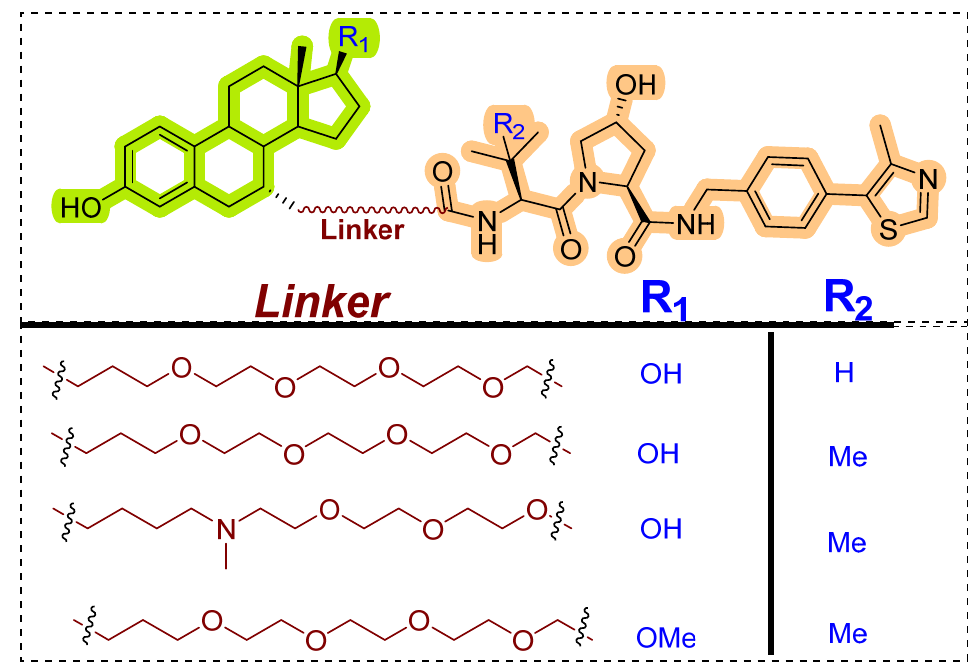
Figure 8. Generalized structure of Patented PROTACs by GSK.